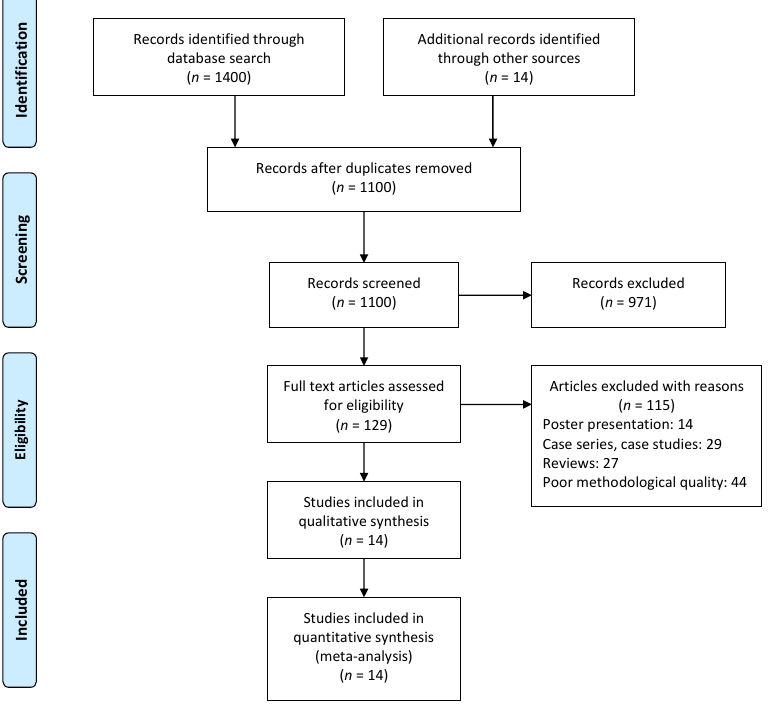
Figure 1. PRISMA Figure 1. PRISMA flowchart.